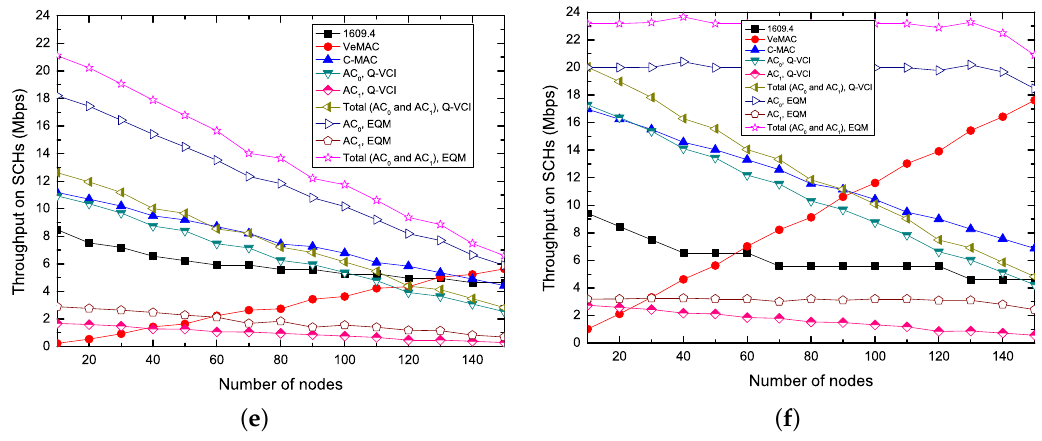
Figure 7. Saturation throughput on SCHs versus the number of nodes for kinds of protocols ( N 0 = N 1 ). ( a ) R S = 1, L data = 1000 bytes; ( b ) R S 0 / S 1 ( d ) R S = 2, L data = 3000 bytes; ( e ) R S 0 / S 1